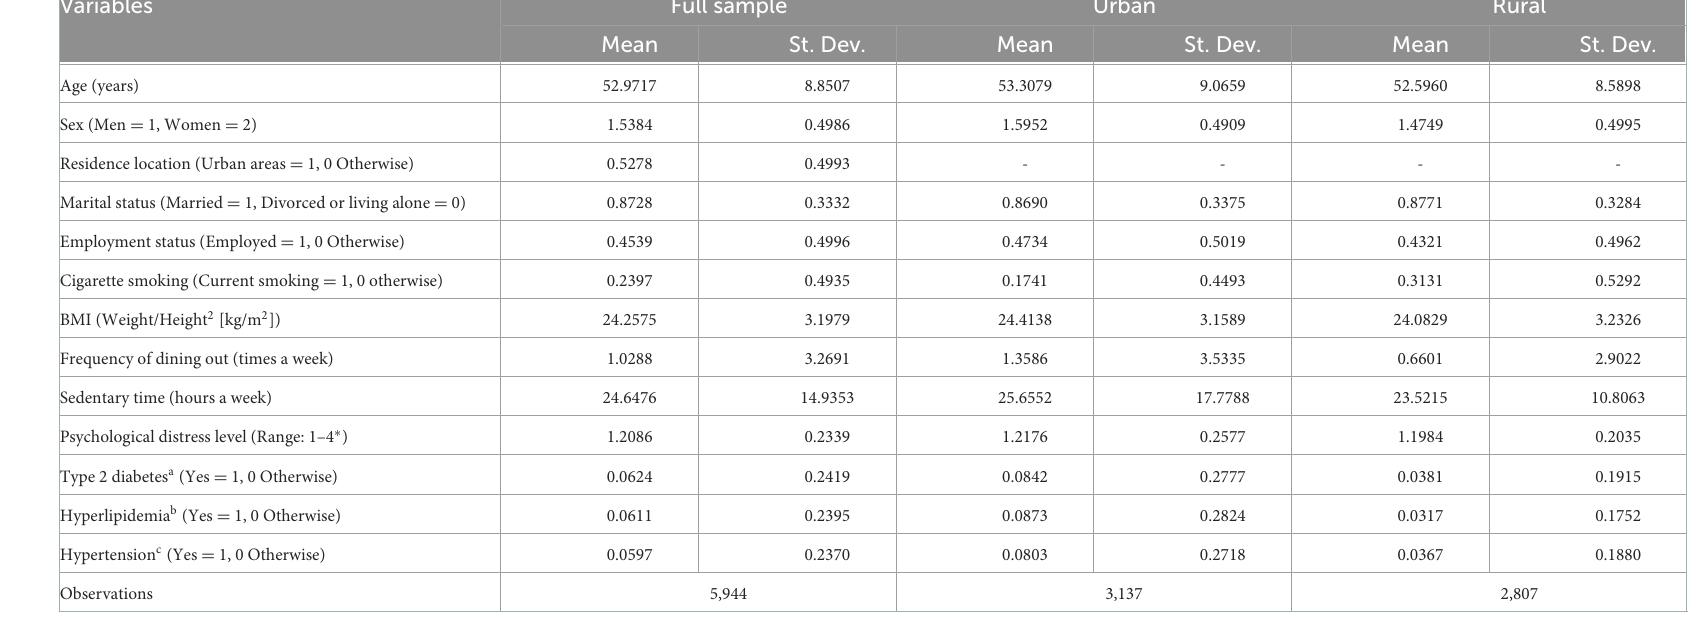
TABLE 1 Participant characteristics in the 2011 baseline